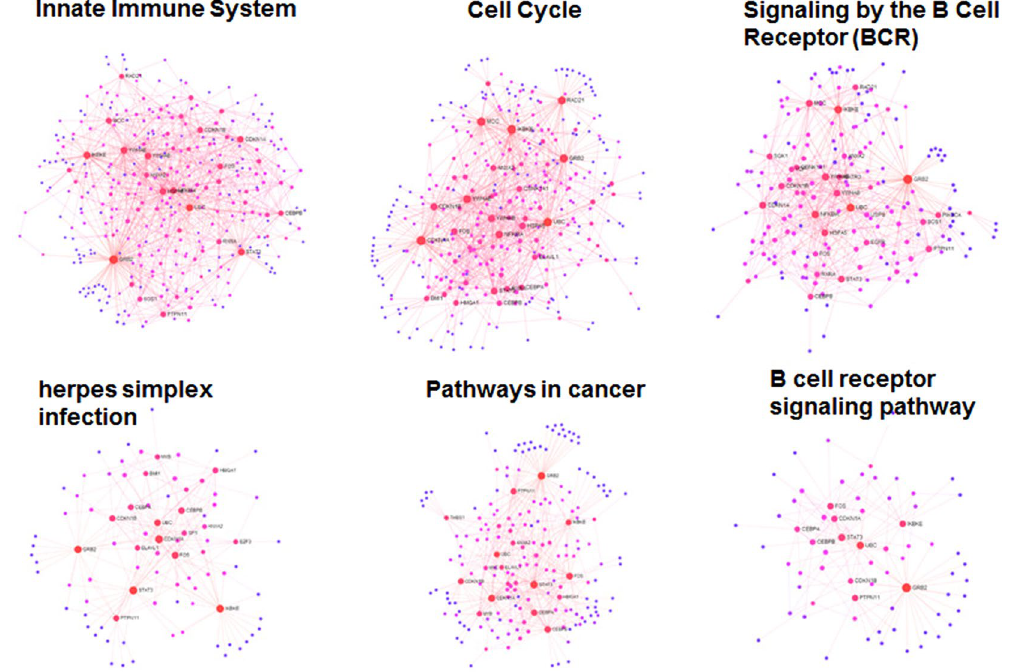
Figure 5. Six extracted functional modules from CePPIN by using enrichment analysis.